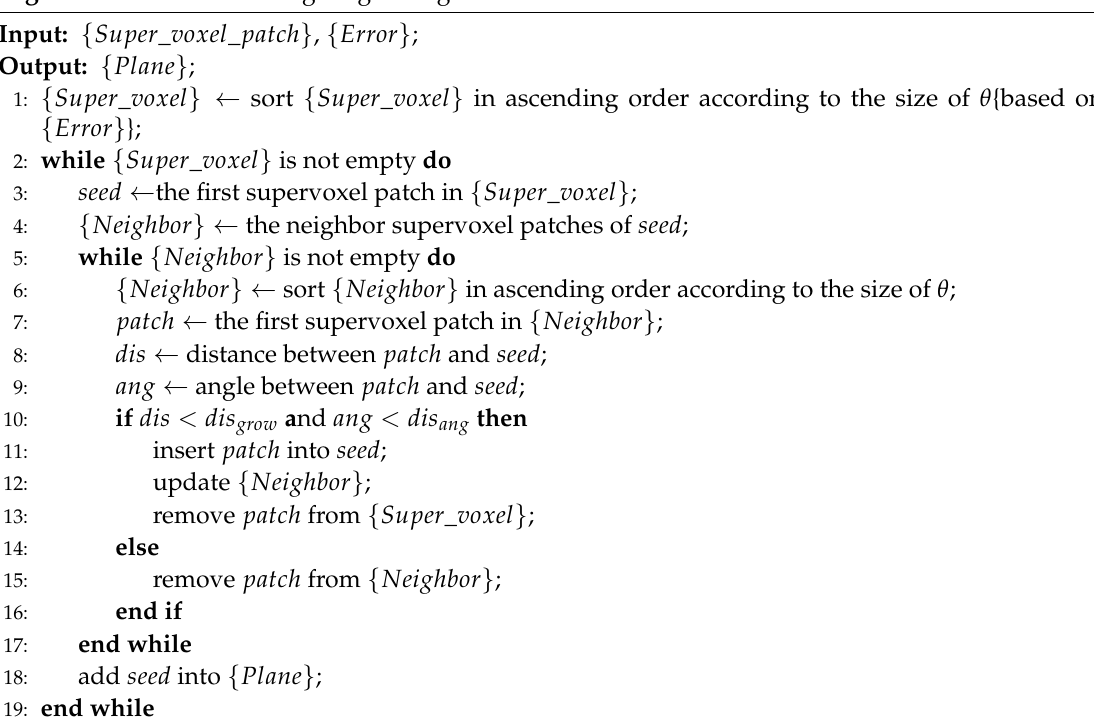
Algorithm 4 Patch-based region growing.